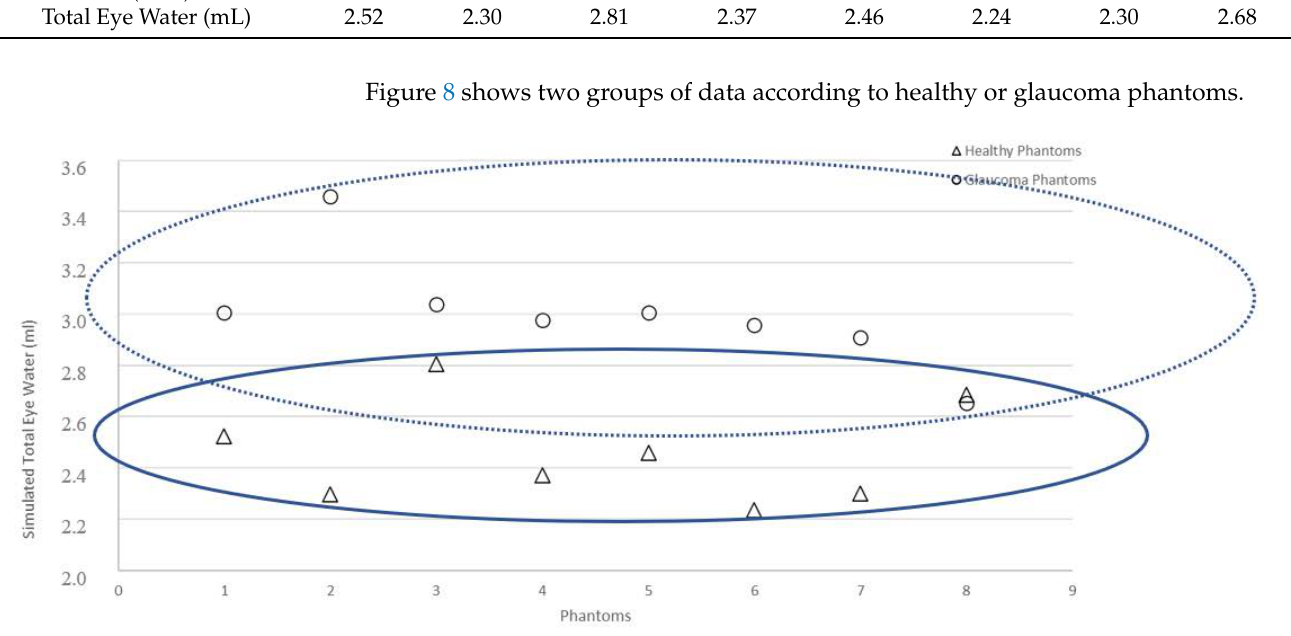
Figure 8. Graphs representing Vt (ml) for each phantom: healthy and simulated glaucoma We observe that three phantoms, G8, S8 and S3 could be interpreted as “healthy” or